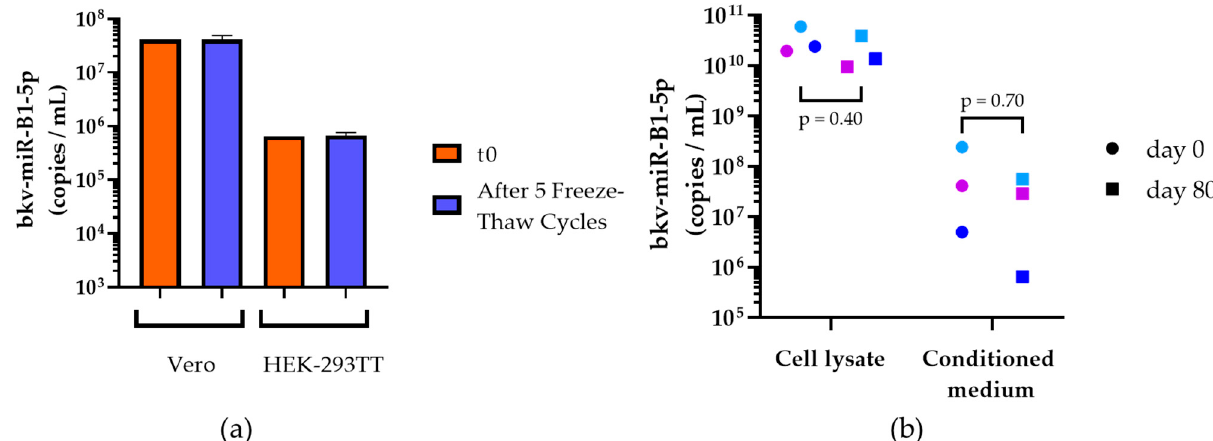
Figure 1. Bkv-miR-B1-5p quantification in samples from in vitro models. ( a ) bkv-miR-B1-5p level in conditioned medium from Vero cells (left) or HEK-293TT cells (right) at the time of collection (orange) or after five freeze–thaw cycles (blue). Colored bars represent mean, and error bars represent the standard deviation of three independent experiments; ( b ) bkv-miR-B1-5p level in cell lysate (left) and conditioned medium (right) from Vero cells infected with BKPyV. Dots correspond to the initial quantities and squares correspond to the quantities measured after 80 days storage at room temperature. Pairs of samples are color matched. p values were obtained by a Mann–Whitney test.